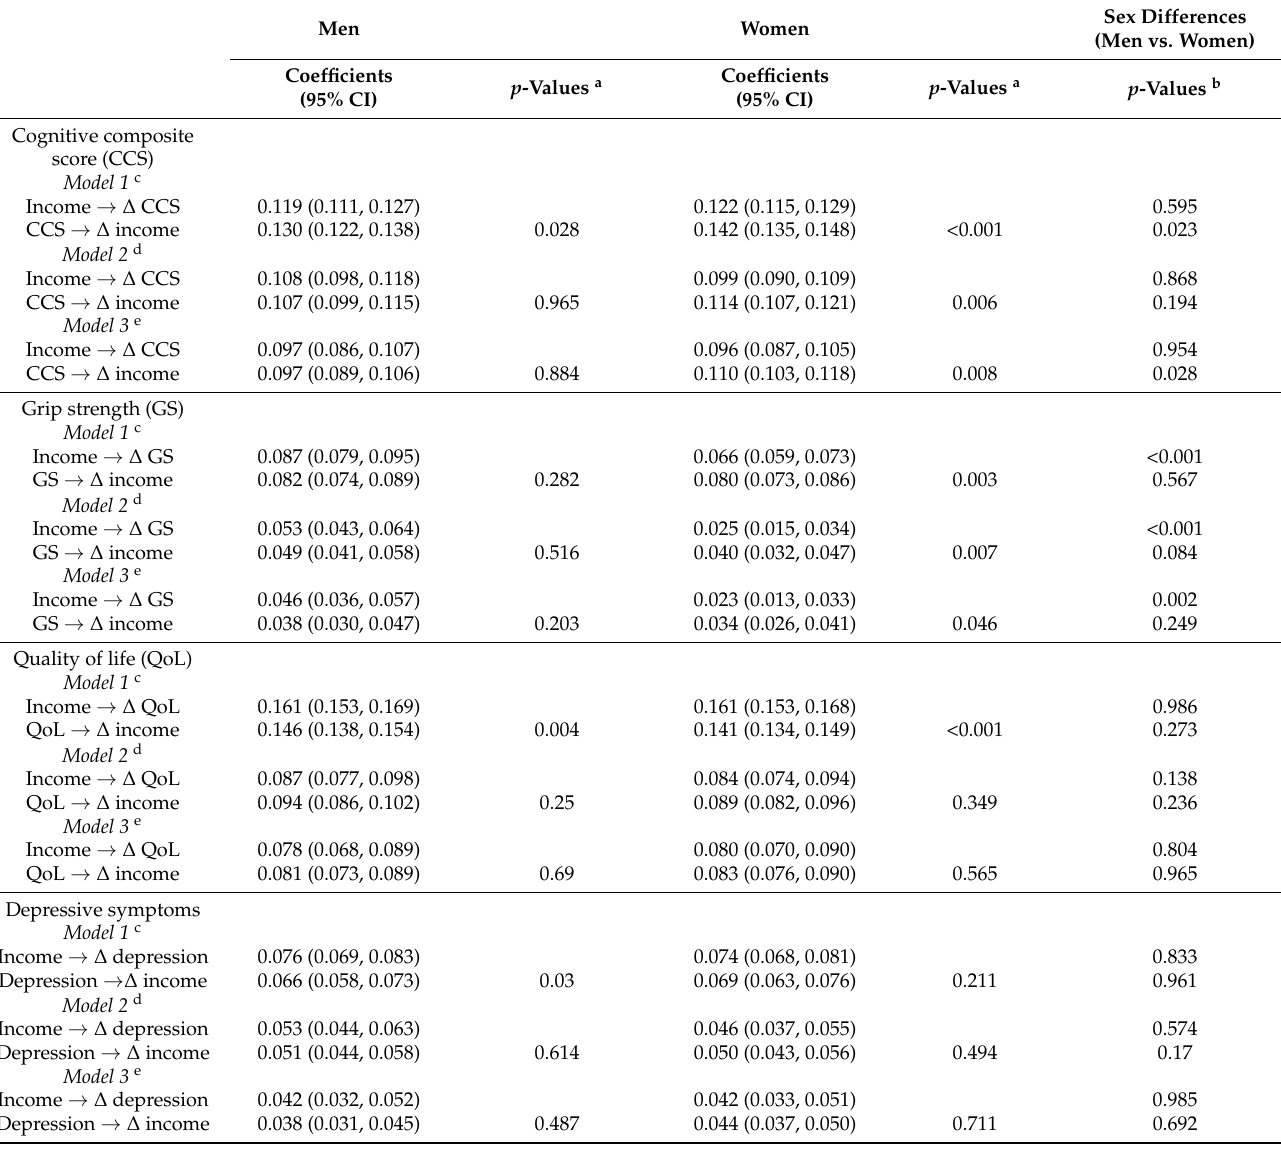
a p -values for differences between the reciprocal associations (i.e., associations between income/wealth and health changes and between health and trajectories of income/wealth). b p -values for sex differences within each of the reciprocal associations. c Model 1: unadjusted. d Model 2: adjusted for age group, European region, wave, and marital status. e Model 3: adjusted for age group, European region, wave, marital status, and